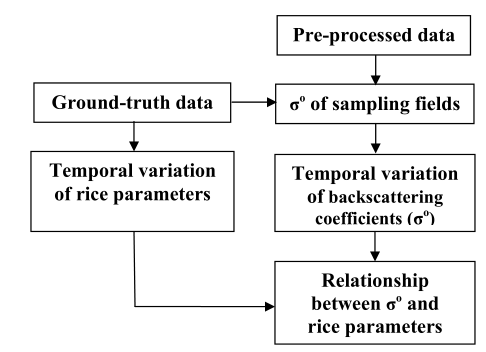
Fig.7: Methods for the analysis of radar backscatter